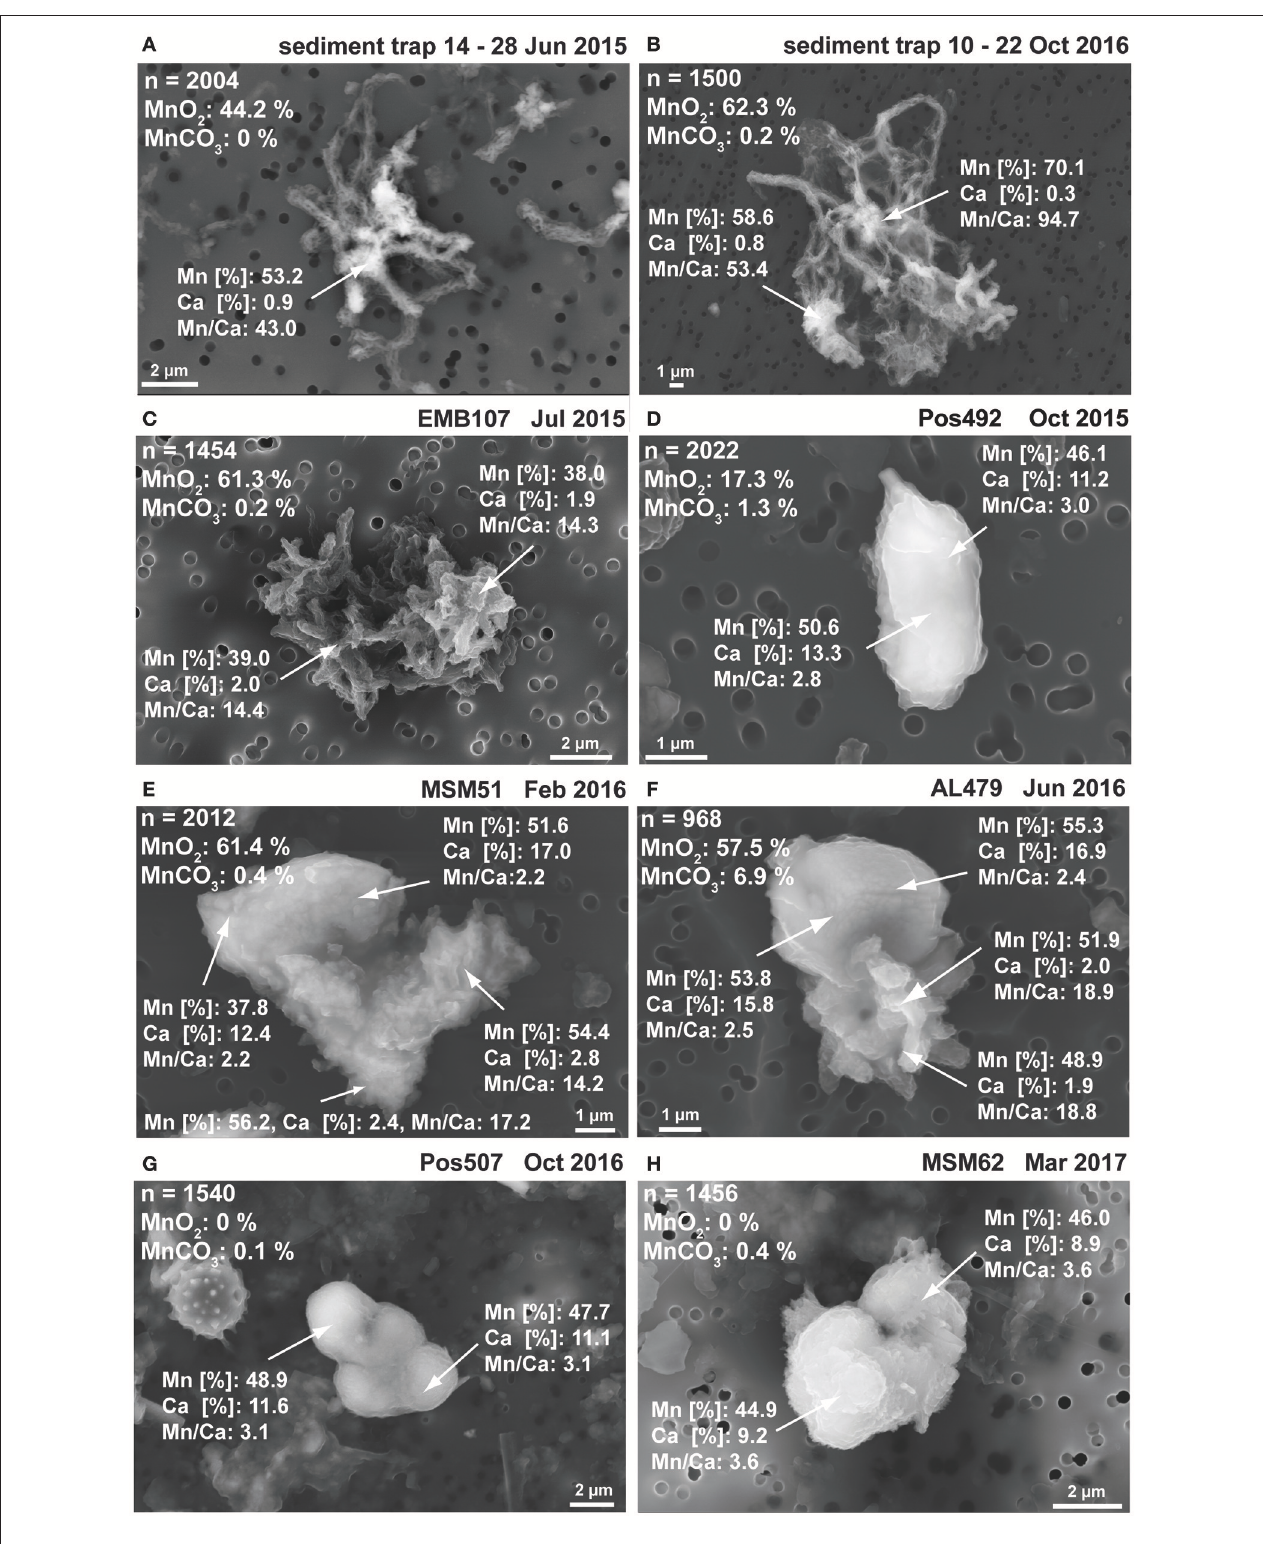
FIGURE 6 | Scanning electron microscopy with energy dispersive X-ray spectroscopy photographs and the results of particle analyses of the Mn mineral phases present in material of the sediment trap (A, B) and in the fluffy surface sediments (C–H) close to station 271 in the central Gotland Basin.